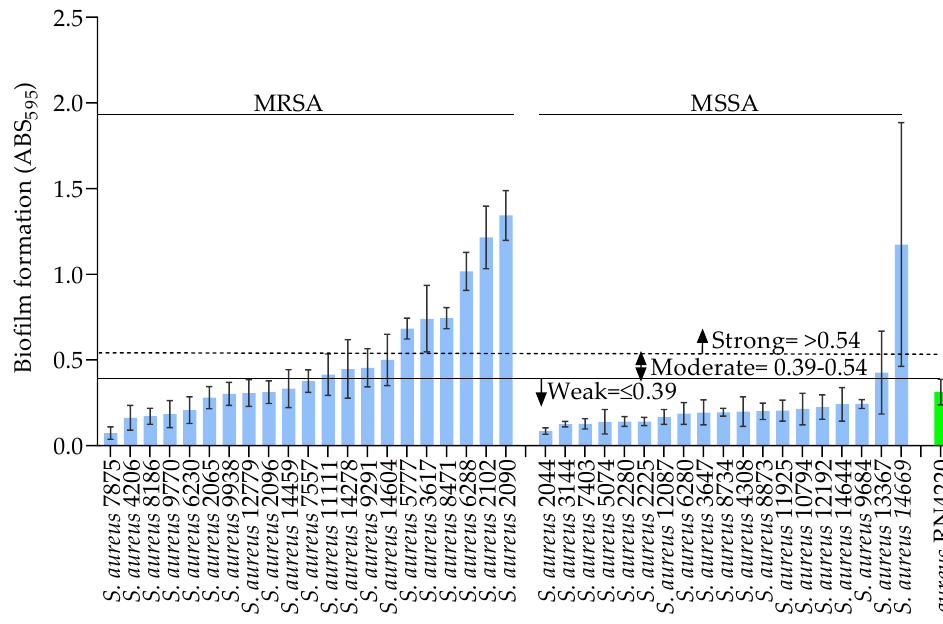
Figure 1. Biofilm formation (ABS 595 ) of MRSA and MSSA strains grown in TSB. The green bar shows results for the positive control strain RN4220. The data show the mean, and error bars represent the standard deviation within the replicates, for at least two independent experiments.